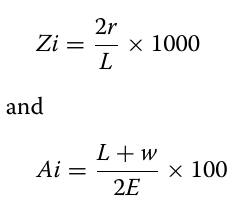
Table 3 Summary of the lithological classes, their description, and main source after Gerth and Becker-Haumann (2007) Lithological